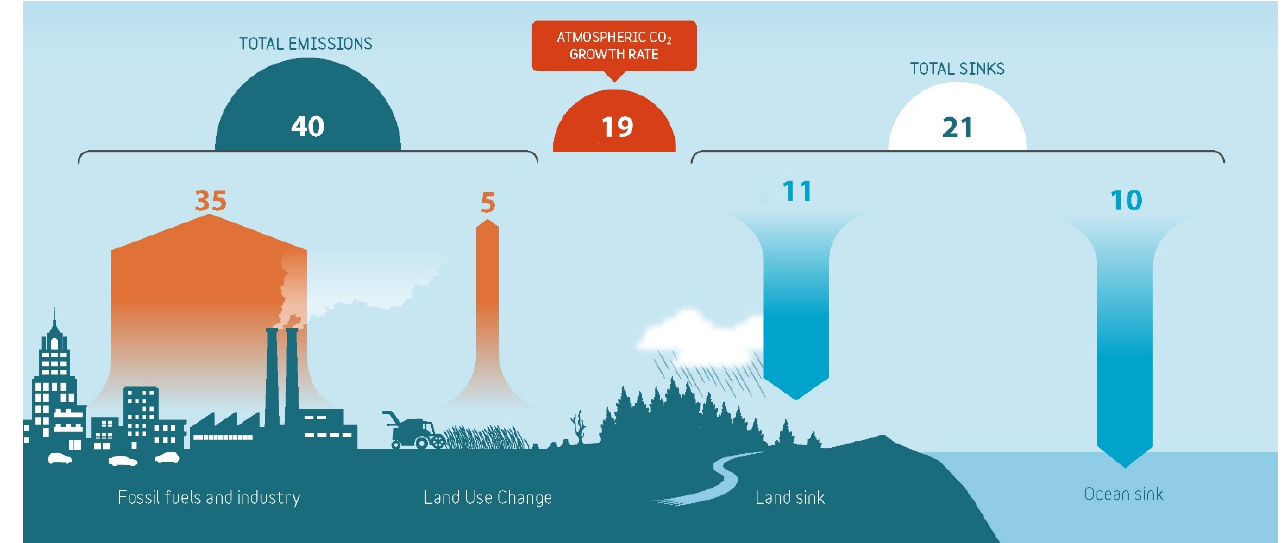
Figure 1. Global CO 2 budget in 2021 modified from Friedlingstein et al. [5].